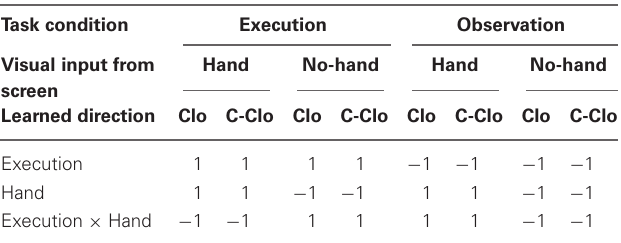
Table 1 | Predefined contrasts for second-level